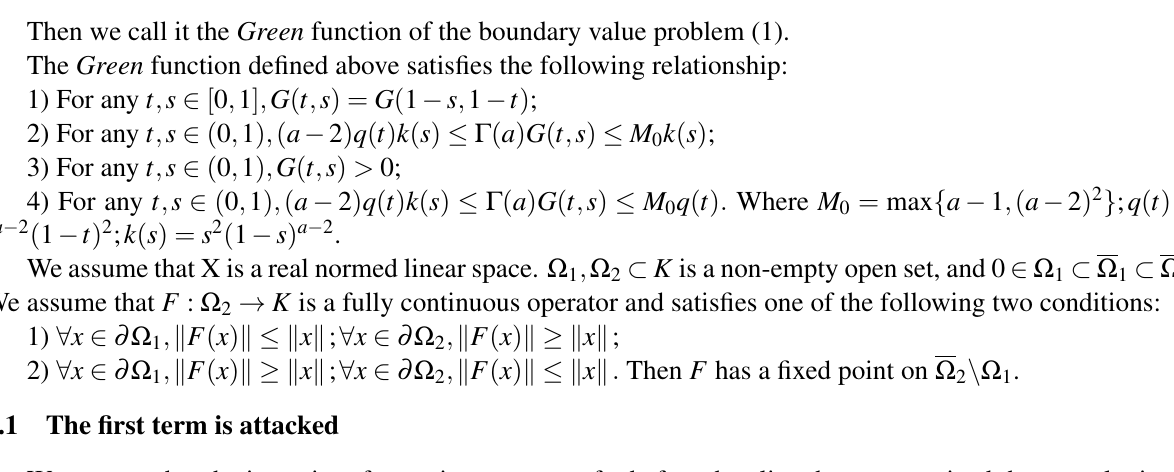
Fig. 1 Green function diagram of a differential